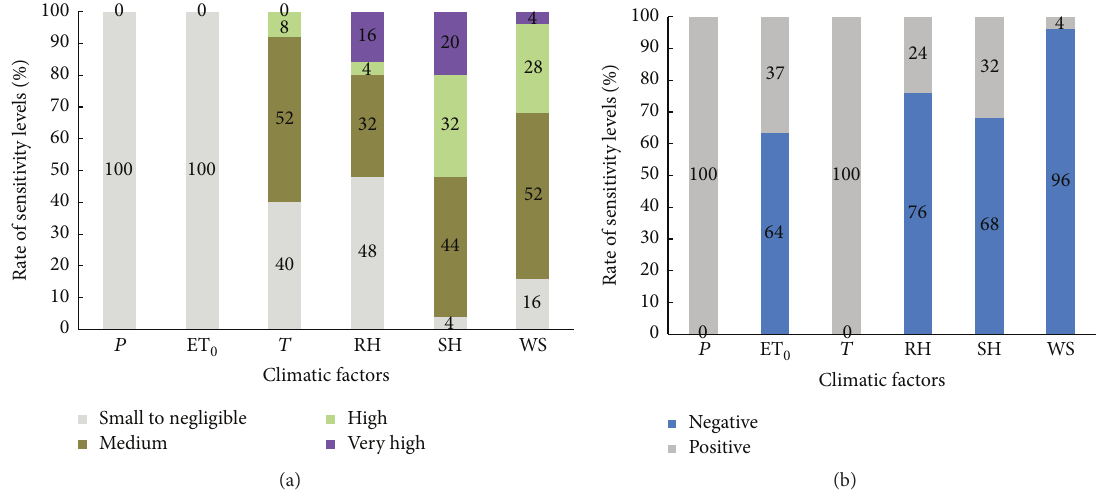
Figure 7: Percentage of the total testing stations distributed over different sensitivity levels (a) and over positive and negative sensitive coefficients (b) among the six meteorological factors in North Xinjiang, China.